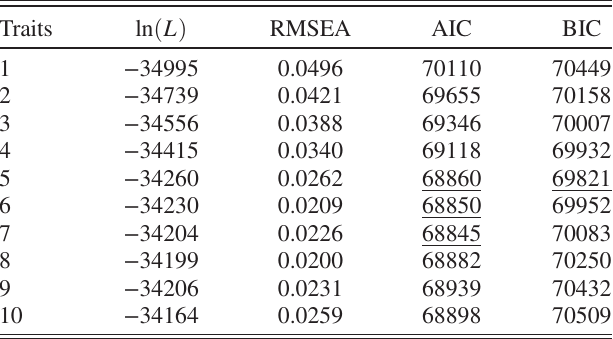
TABLE I. Statistical measures of IRT models with varying number of traits are tabulated as calculated by MIRT . The root mean square error of approximation (RMSEA) is provided here to show that all models fit the data acceptably well. The two dominant information criteria, AIC and BIC, are given with the minima underlined. Although the strict minimum AIC value corresponds to n ¼ 7 , this minimum is quite shallow and may only be the artefact of the optimization procedure. Contrary to AIC, the Bayesian Information Criterion has a well-defined minimum at n ¼ 5 .